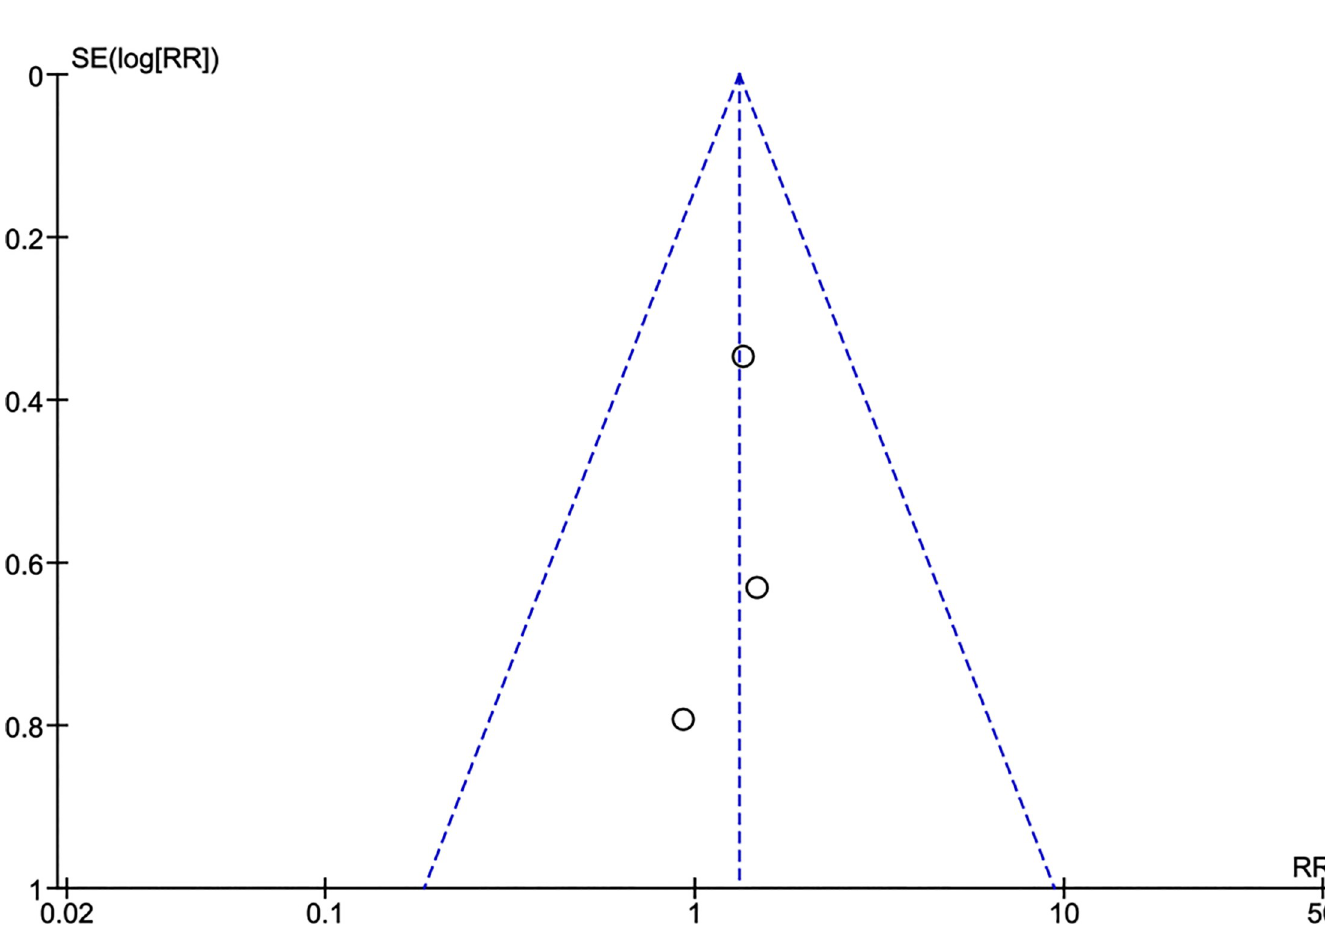
Fig 11. Funnel plot anti-seizure medication. 6 months ASM versus 12–24 months ASM. Outcome: seizure recurrence.